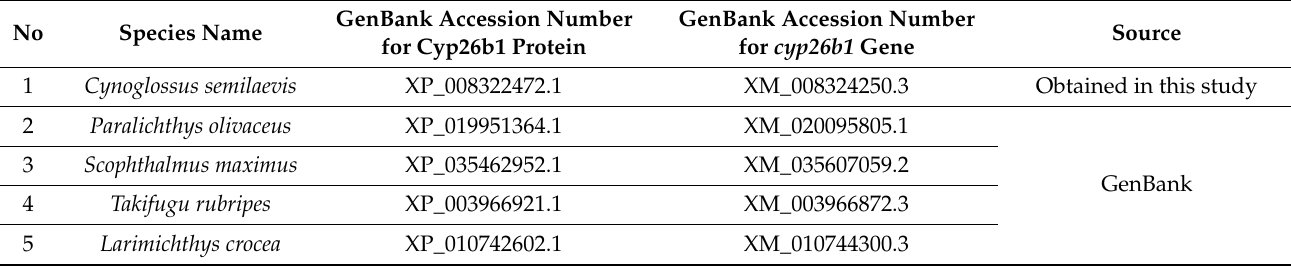
Table 3. Table list of species used in multiple alignment.